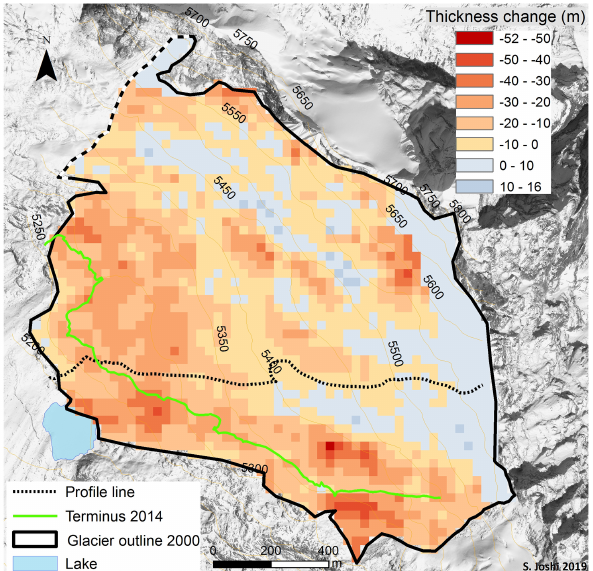
Figure 7. Thickness changes of Yala Glacier in metres after DEM differencing of GeoEye-1 (January 2012) and SRTM-3 (Febru- ary 2000) DEM and dGNSS profile in 2012.